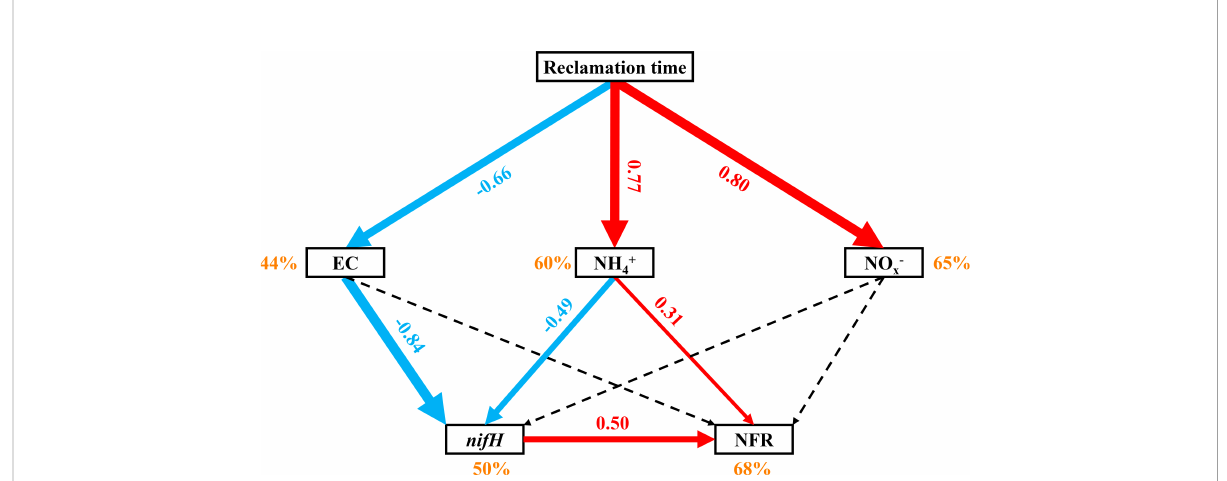
FIGURE 6 Predicted path models relating reclamation time to N fi xation rates (NFR). Solid red lines indicate signi fi cant positive effects, solid blue lines indicate signi fi cantly negative effects, and black dashed lines indicate insigni fi cant effects. Numbers adjacent to the lines are standardized path coef fi cients, also shown by the width of the lines. Percentages adjacent to the variables indicate their explained